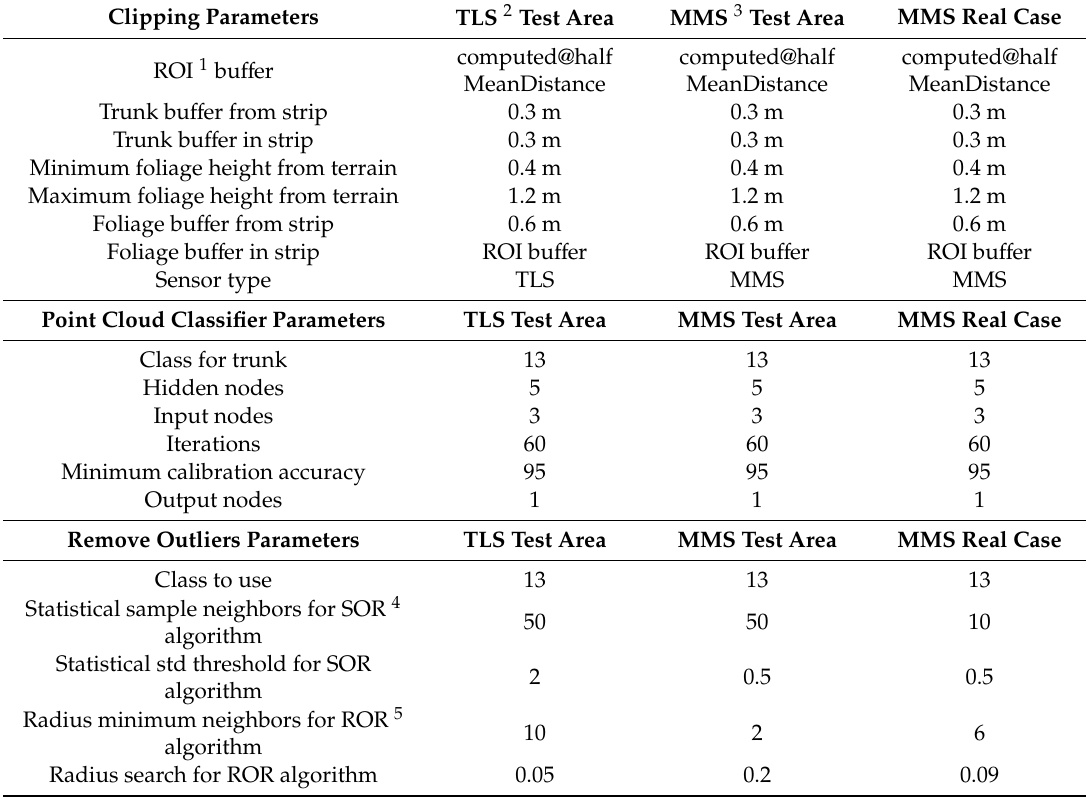
Table 8. List of the utilized parameters in preprocessing